Question: What caption would you write for this figure?
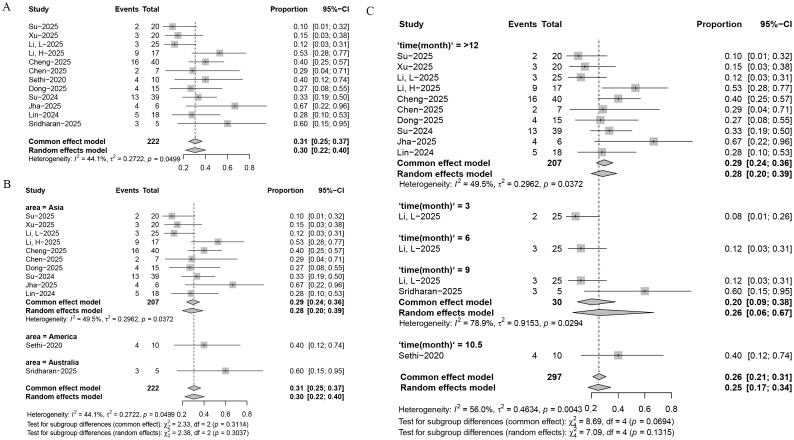
Answer: (A) Forest plot of the complete clinical remission rate; (B) Forest plot of the subgroup analysis of area for the complete clinical remission rate; (C) Forest plot of the subgroup analysis of follow-up time for the complete clinical remission rate.